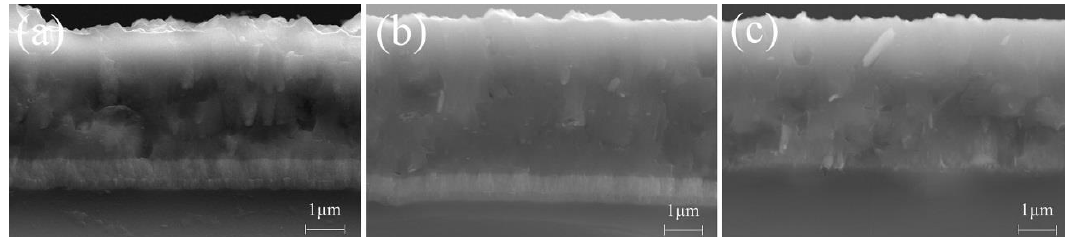
Figure 4. Fractured cross-sectional SEM images of the three coatings: ( a ) AlCrSiN coating, ( b ) AlCrSiON coating, ( c ) AlCrSiN/AlCrSiON duplex coating.